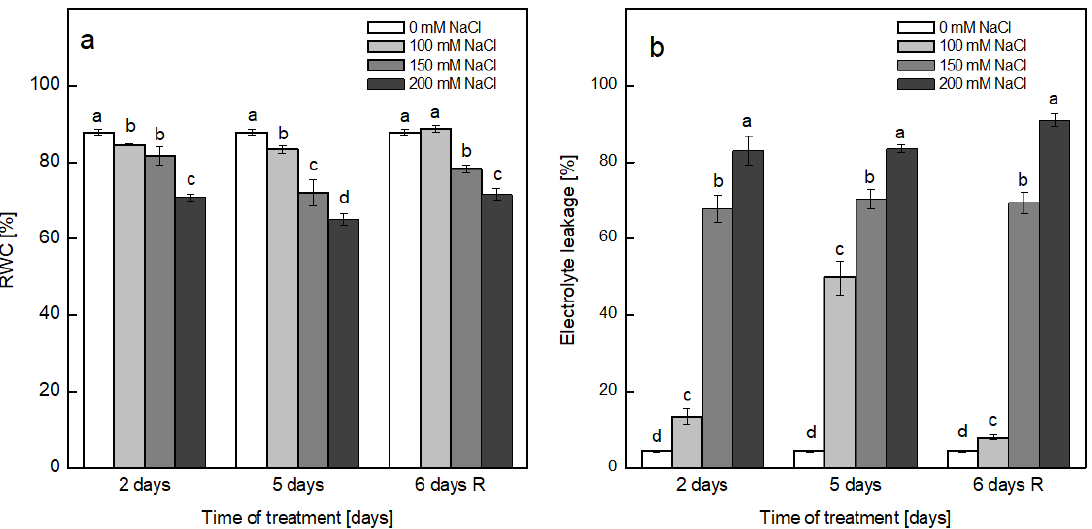
Figure 1. Salt-induced alterations in the relative water content (RWC) ( a ) and electrolyte leakage (EL) ( b ) of the leaves of pea plants after treatment with 0, 100, 150 and 200 mM NaCl for 2 and 5 days and after recovery (6 days R) on pure Hoagland’s solution. Results are presented as means ± SE. Three independent experiments were performed with 3 parallel samples at each time point ( n = 9). Different letters indicate significant differences between the values for the control plants (0 mM NaCl) and plants treated with increasing concentrations of NaCl at p < 0.05 for the respective period of the experimental setup (2 and 5 days of treatment and the recovery period).